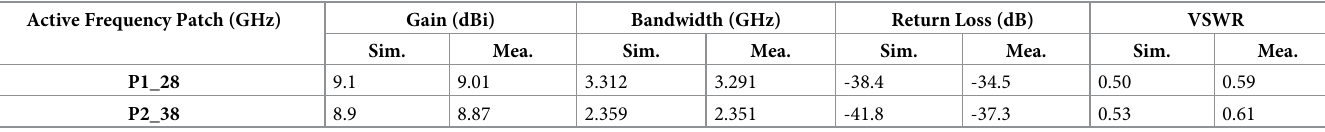
Table 1. Performance of the proposed mathematical model antennas. Active Frequency Patch